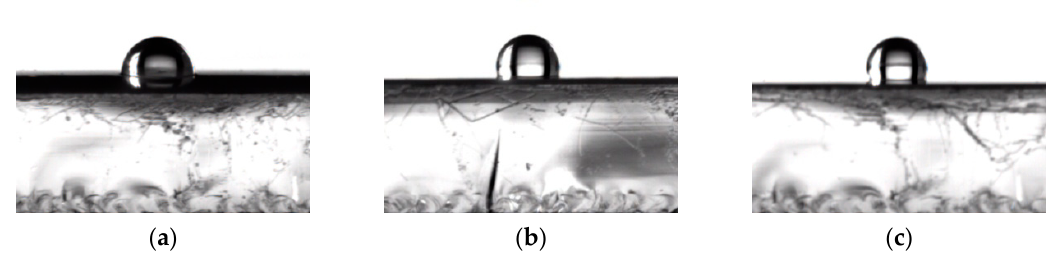
Figure 5. Static contact angle graphs of different films. ( a ) Control; ( b ) 3% TiO 2 -N; and ( c ) 9% CO-3% TiO 2 -N.